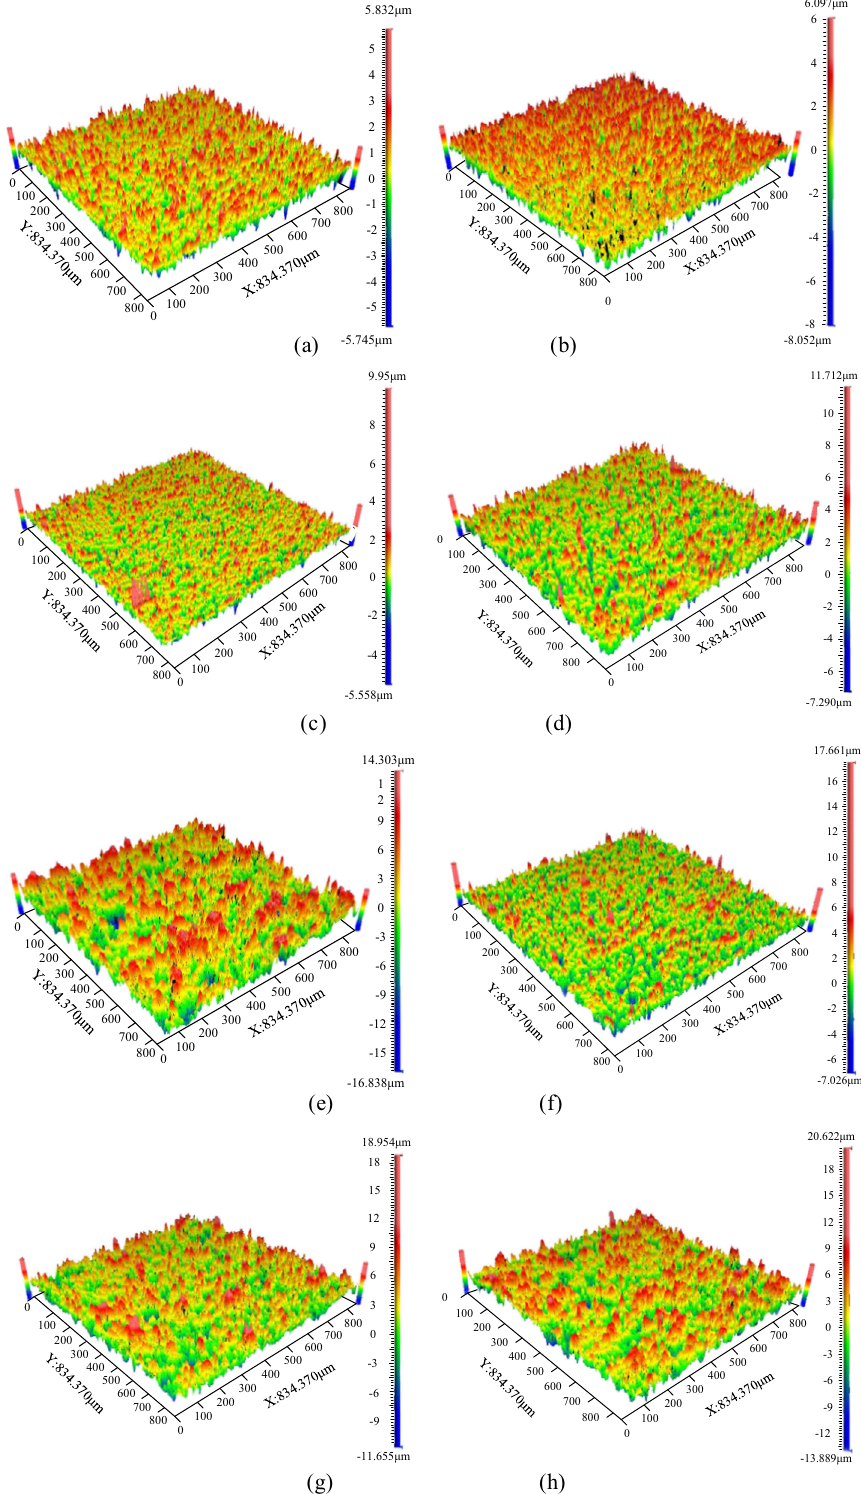
Figure 1: The surface morphology and surface roughness in Table 3: ( a ) 6th group, ( b ) 15th group, ( c ) 1st group, ( d ) 16th group, ( e ) 13th group, ( f ) 11th group, ( g ) 3rd group, and ( h ) 10th